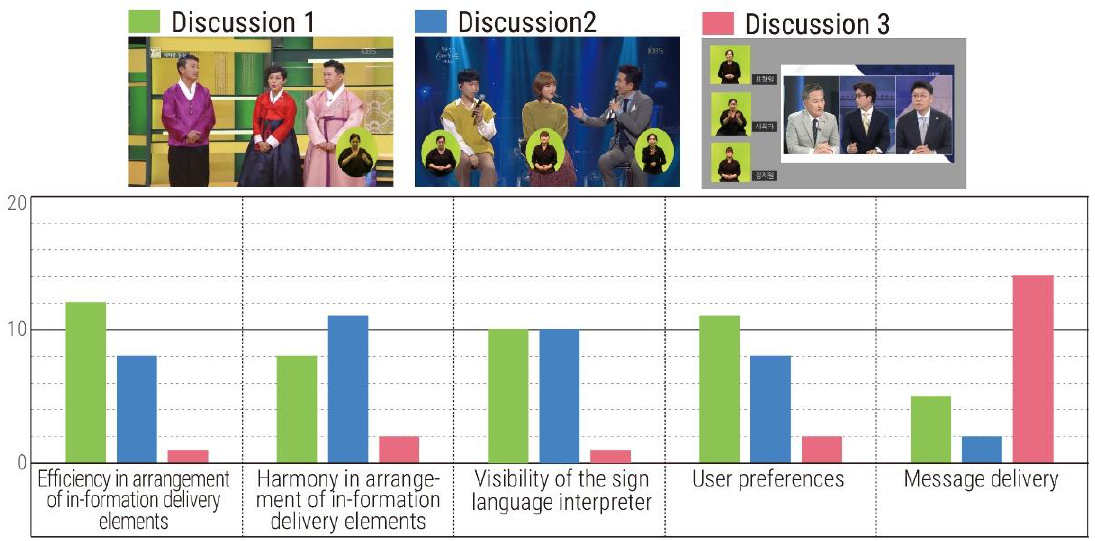
Figure 13. Results of experiments in panel discussion cases.